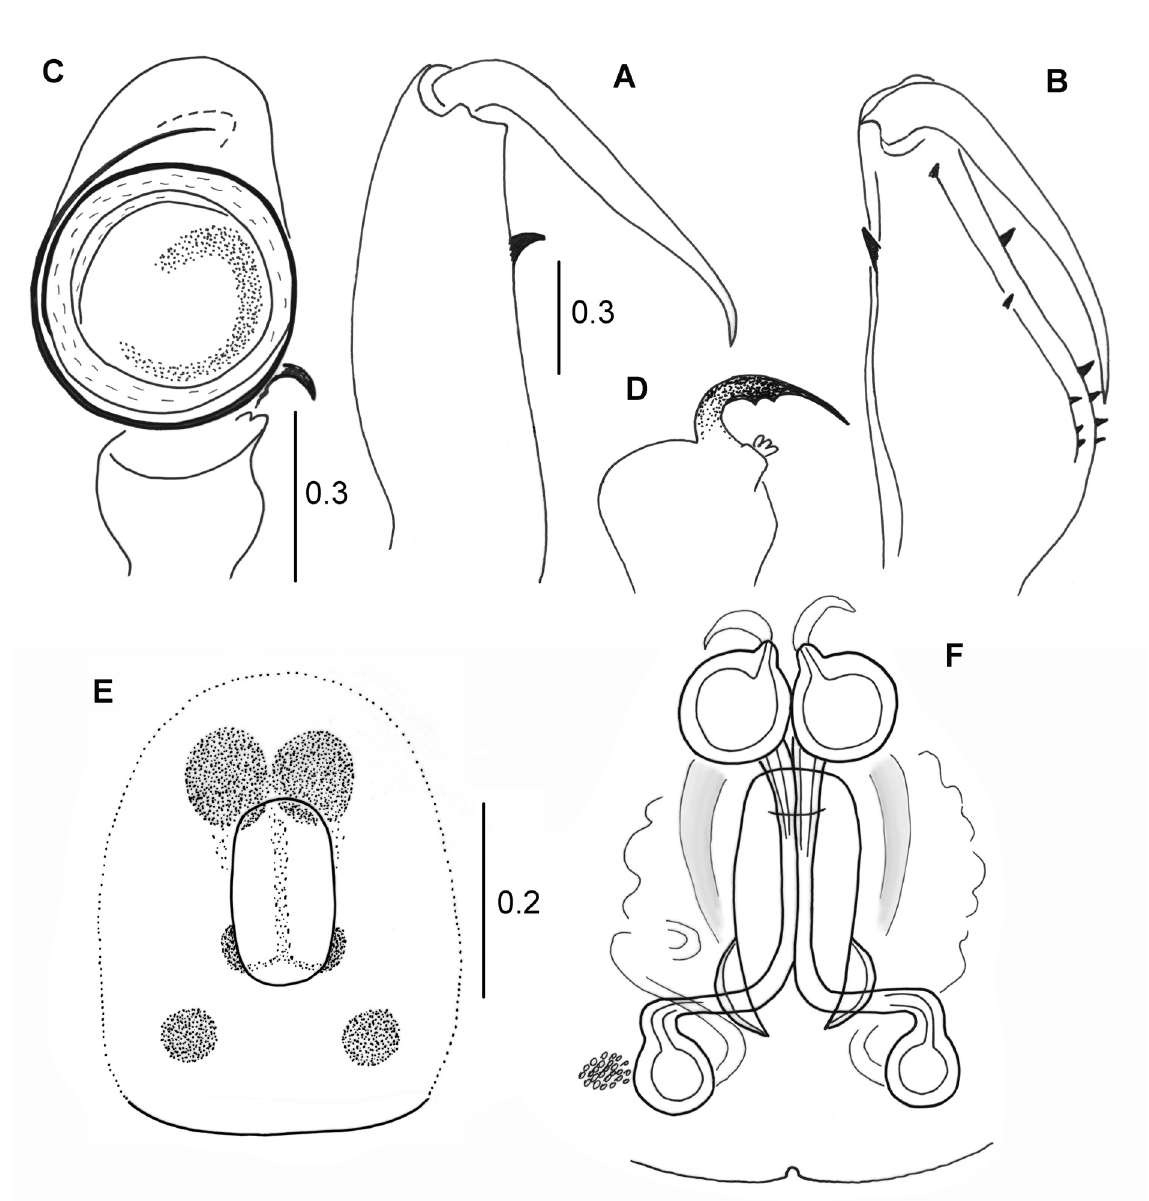
Fig. 12. Belippo milloti (Lessert, 1942), ♂♀ (MNHN). A . Male chelicera, dorsal view. B . Male chelicera, ventral view. C . Palpal organ, ventral view. D . Palpal tibia, ventral view. E . Epigyne. F . Internal structure of